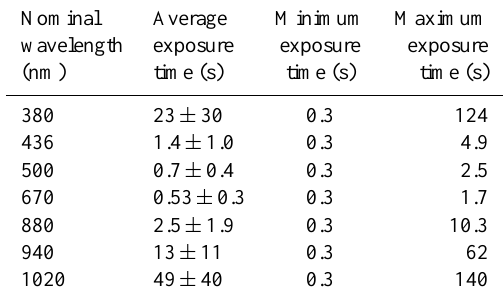
Table 1. Mean, maximum and minimum exposure times for each filter of the star photometer